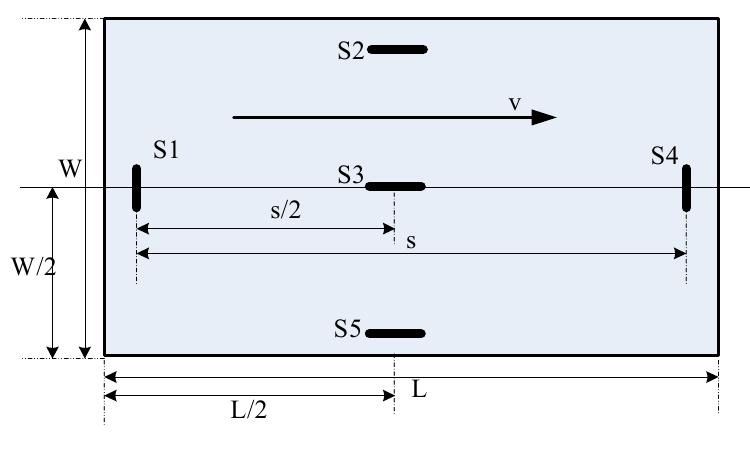
Figure 1 .The layout plan of the strain gauge sensors.